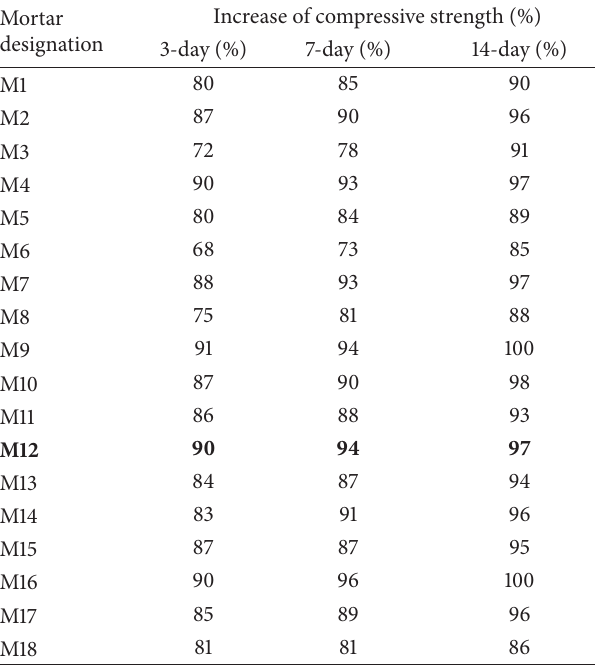
Table 5: The percentage (%) increase in the compressive strength at 3, 7, and 14 days compared with the 28-day